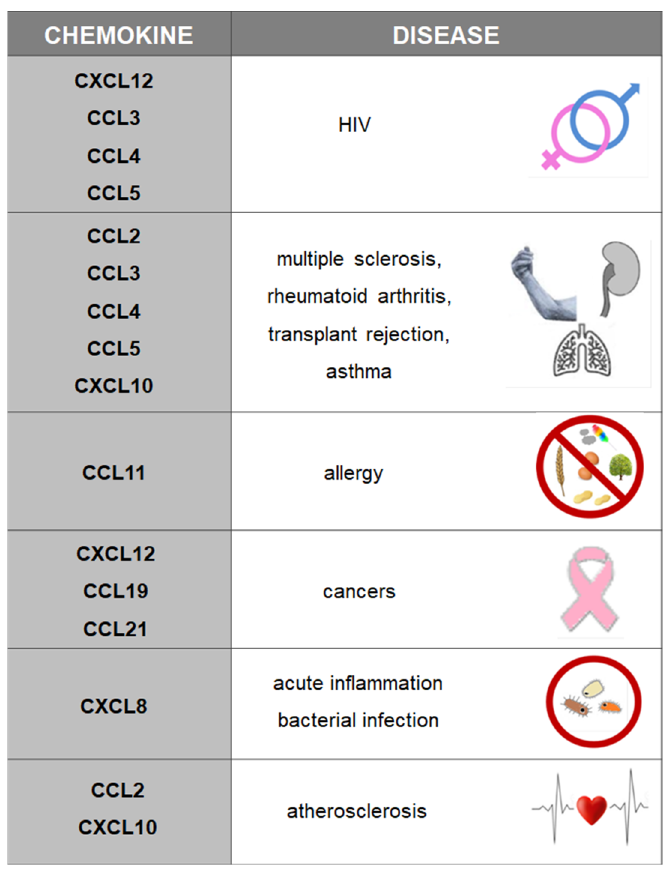
Figure 2. Chemokines and the associated